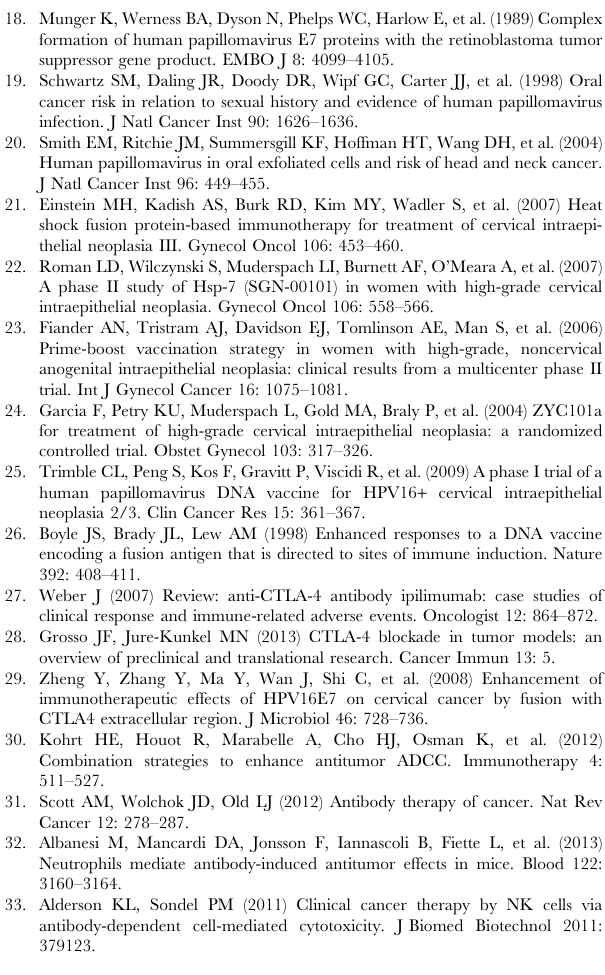
Figure S2 Anti-CTLA-4 antibody levels in therapeutic (A) or preventive (B) vaccination. The levels of specific anti- CTLA-4 serum IgG were determined by ELISA assay. The antibody levels of each group were presented as mean OD values 6